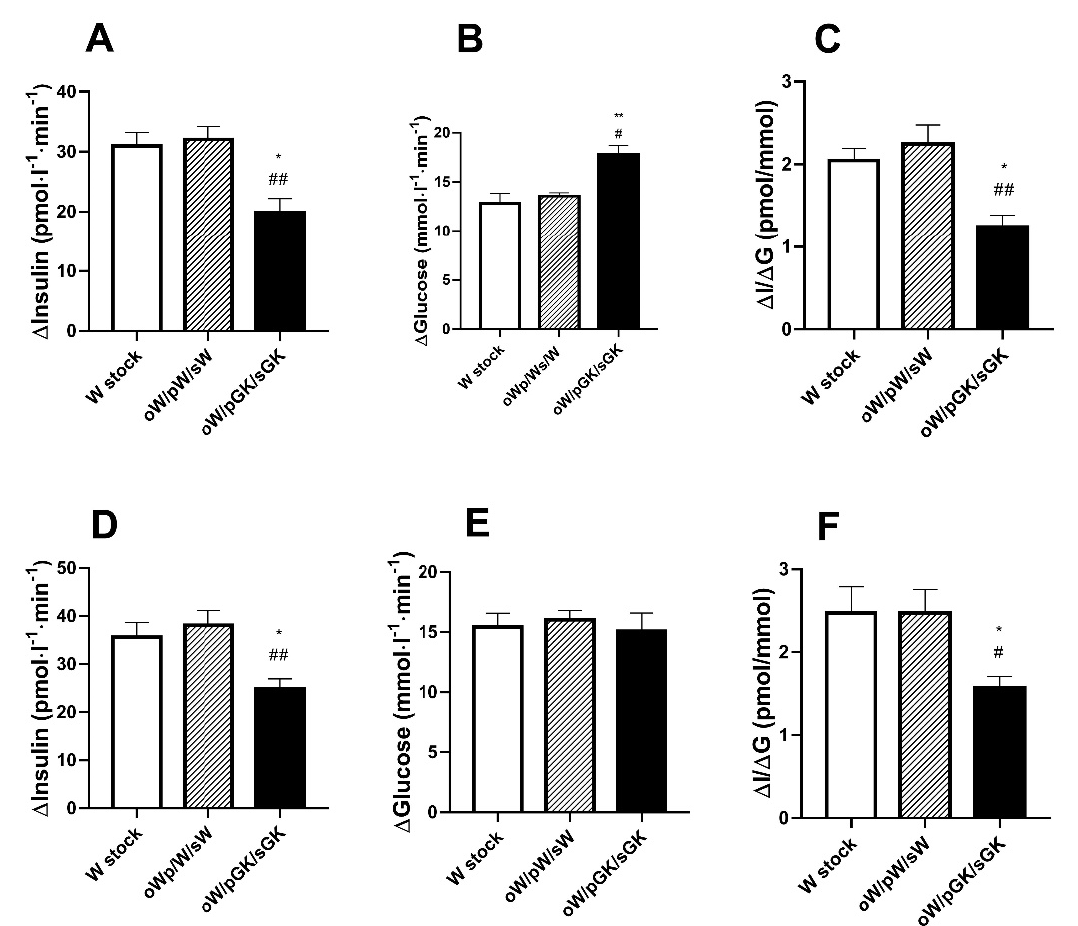
Figure 3. Glucose tolerance ( ∆ G ), glucose-stimulated insulin secretion ( ∆ I ) and insulinogenic index ( ∆ I / ∆ G ) in 10-wk-old male ( A – C ) or female ( D – F ) rats. Animals were obtained from W ovocytes (oW), transferred into W mothers (pW) and reared with W dams (oW/pW/sW group) or obtained from oW ovocytes, transferred into GK mothers and reared with GK dams (oW/pGK/sGK group). They were compared to control W rats (W stock, no transfer). oW: Wistar ovocyte; pGK: pregnant GK mother; pW: pregnant W mother; sGK: suckling GK mother; sW: suckling W mother. In vivo glucose tolerance and insulin secretion were tested in response to an intravenous (i.v.) injection of glucose (0.5 g/kg body weight) in anesthetized rats (post-absorptive state). Values are mean ± SEM. Nine to twelve rats were analyzed per experimental group. * p < 0.05; ** p < 0.01; as compared to value in sex-related oW/pW/sW group. # p < 0.05; ## p < 0.01 as compared to value in in sex-related W stock group. Table 2. Changes in body weight, basal plasma glucose level (post-absorptive state), pancreatic insulin stores and pancreatic beta cell mass in 4- and 8-wk-old male rats issued from W neonates (nW) suckled by W foster mothers (nW/sW group) and in 4- and 8-wk-old male rats issued from W neonates suckled by GK foster mothers (nW/sGK group). Basal Plasma Pancreatic Insulin Body Weight Pancreatic Beta Cell Age Rats Glucose Stores (g) (%) (mmol/L) (pmol/mg pancreas) 4 wks nW/sW nW/sGK nW/sGK 212 ± 9 (9) **, p < 0.01 as compared to related value in the age-related nW/sW group. ND: not determined. ( ): number of individuals in each